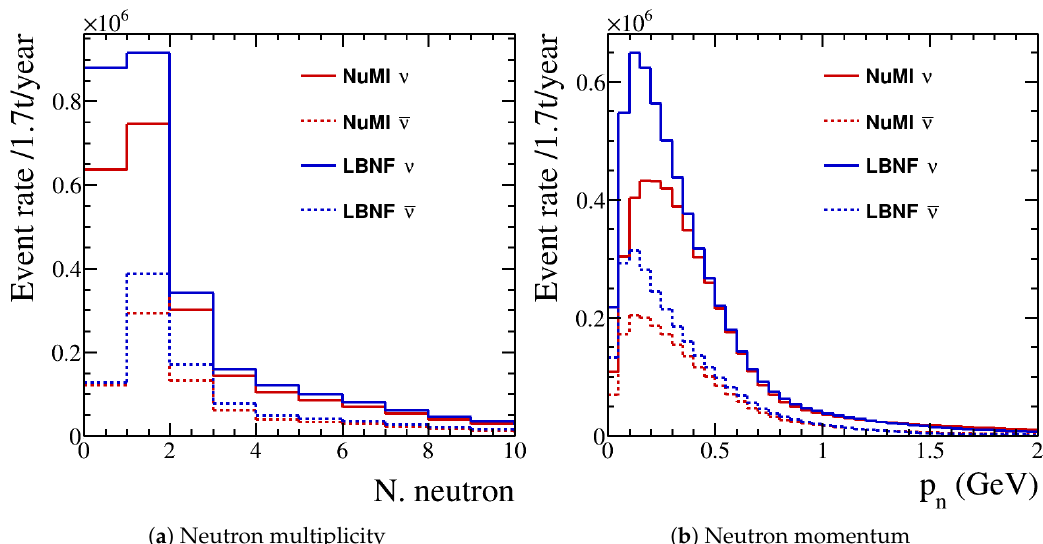
Figure 23. The expected yearly rates of neutrons produced at the vertex, as a function of event multiplicity and their momentum, expected in the the demonstrator’s 1.7t LAr mass for the NuMI ME and LBNF fluxes, produced using GENIE v2.12.10 [71]. Note that every neutron from each event is included in the momentum